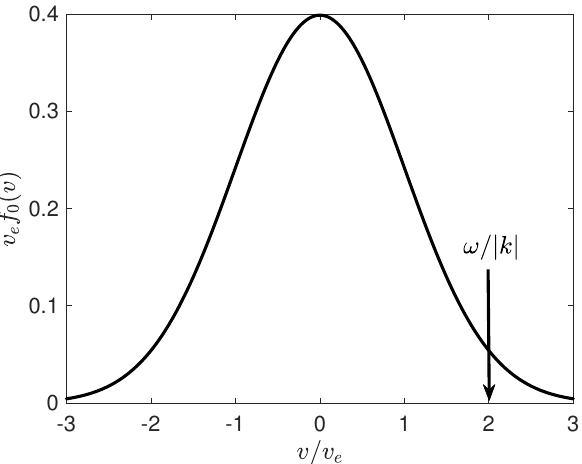
Figure 1. Maxwellian distribution. The arrow points to the location of the phase speed ω / | k | of the Langmuir wave. In the considered case, the wave speed is larger than the electron thermal speed. Particles to the left of the arrow are slower, and particles to the right of the arrow are faster than the wave. Here we have used the wave number k , the frequency ω , the electron speed v , and the electron thermal speed v e